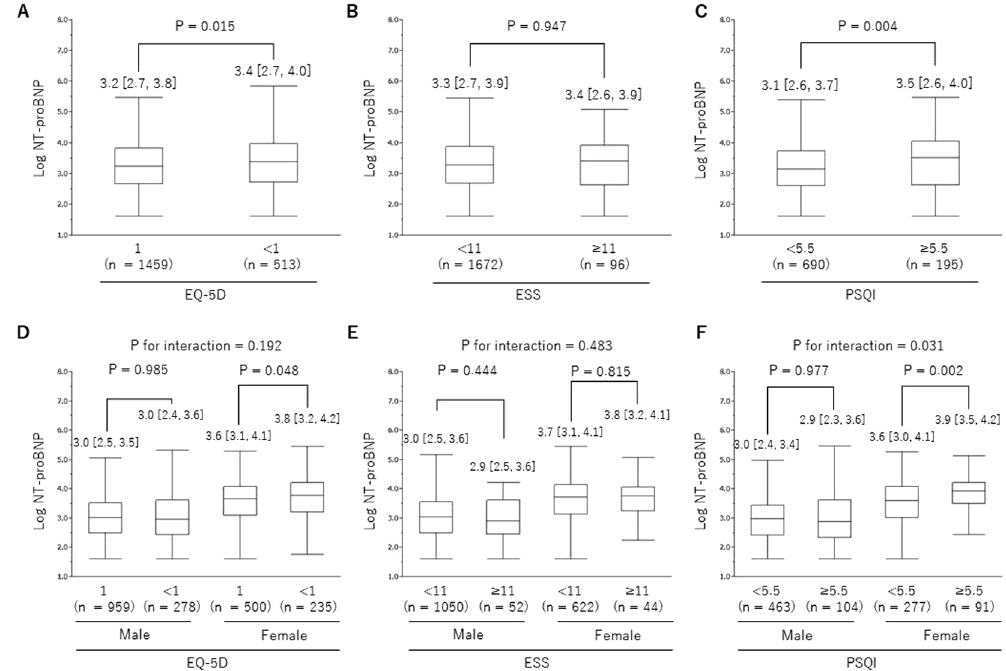
Figure 4. Influence of HR-QOL on NT-proBNP. EQ-5D in the total cohort ( A ) and by sex ( D ). ESS in the total cohort ( B ) and by sex ( E ). PSQI in the total cohort ( C ) and by sex ( F ). Each P value to compare between groups were calculated by Mann-Whitney U